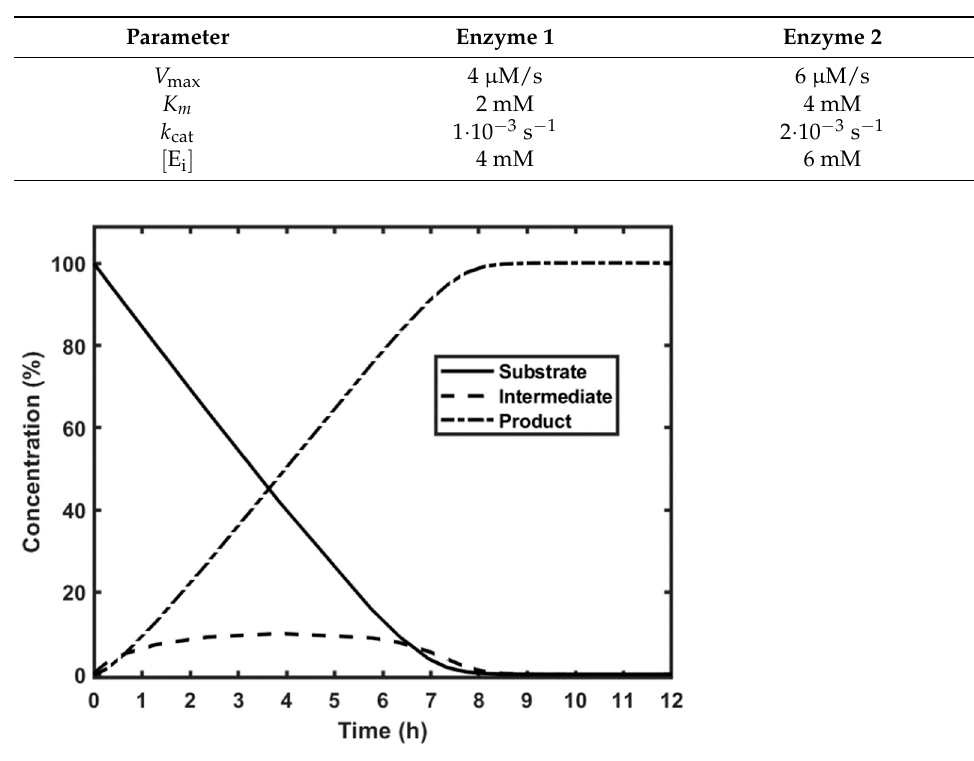
Table 1. Assumed kinetic parameters for enzymes 1 and 2.